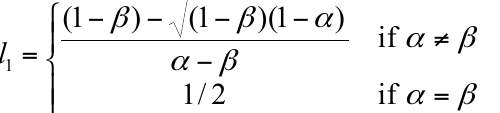
Figure 1. Proportion l as a function of the payoffs α and β , with mutation fractions m